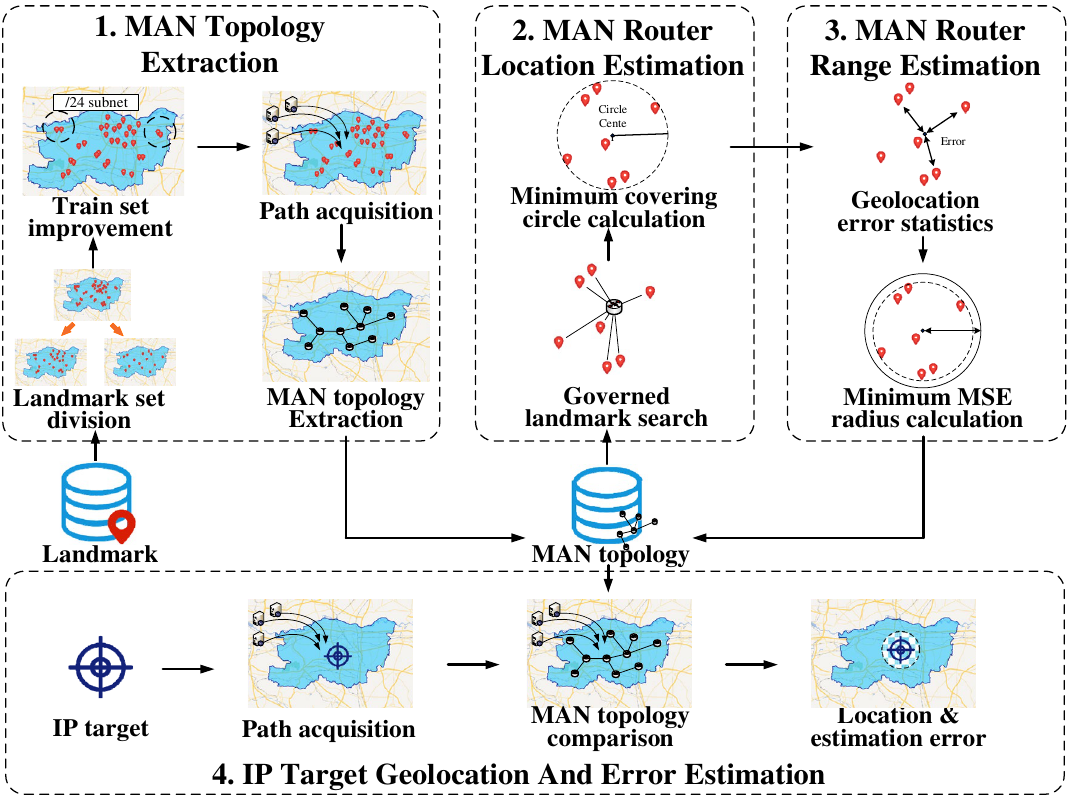
Figure 2. An overview of the IP target location estimation method